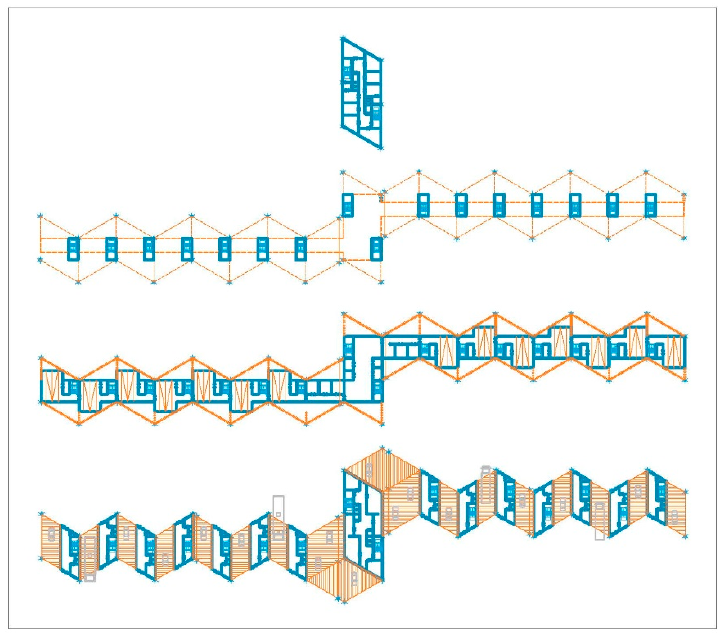
Figure 13. Planning solutions: the Special vehicle control point (levels 1, 2, 3, 4).